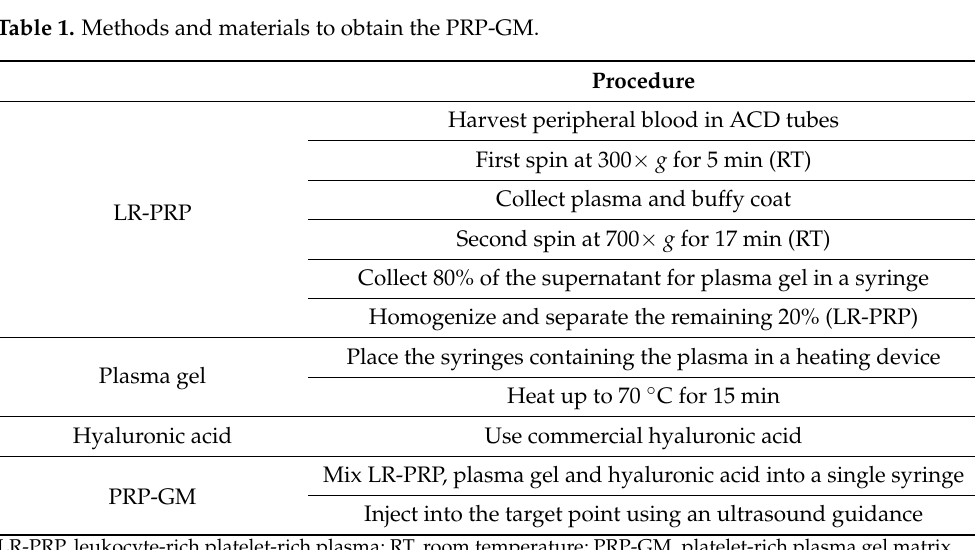
Figure 5. Illustrated chart representing the method for obtaining the PRP-GM. ( 1 ) PRP is prepared as previously described [10]; ( 2 ) The collected plasma is heated up to 70 °C for 15 min in order to form a gel; ( 3 ) The plasma gel and buffy coat are mixed into a syringe; ( 4 ) Hyaluronic acid is added to the mix; ( 5 ) Schematic illustration of all of the components present in the PRP-GM. Table 1. Methods and materials to obtain the PRP-GM. Procedure LR-PRP